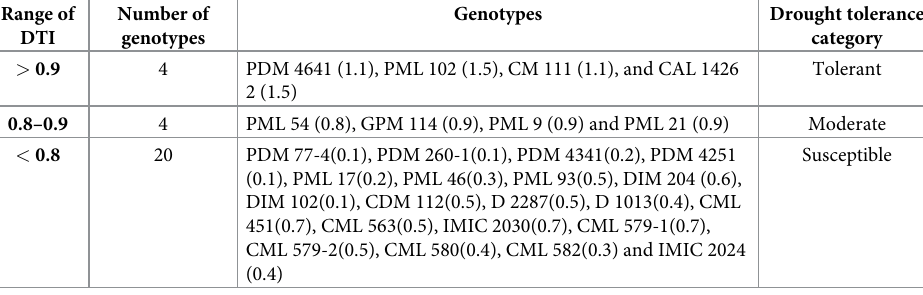
Table 8. Grouping of corn inbreds based on drought tolerance index (DTI).